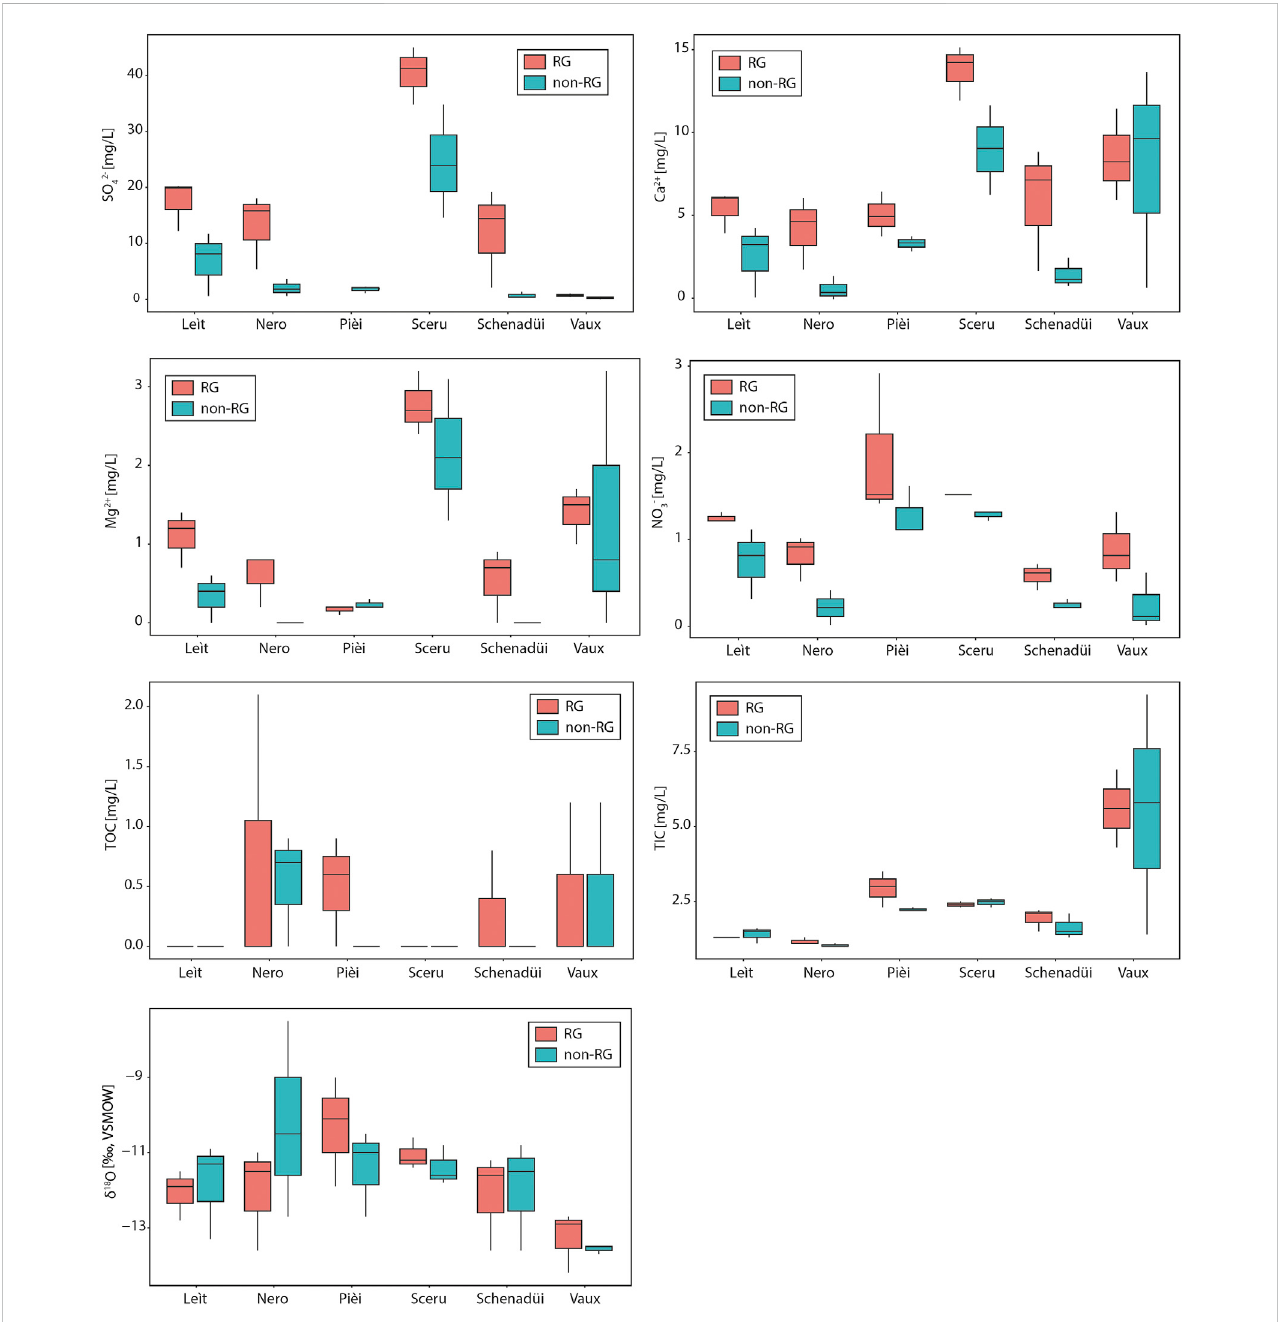
FIGURE 8 Distribution of ion and isotopic values measured in RG and non RG springs during the warm season.